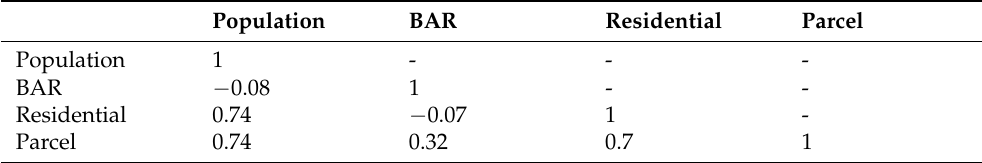
Table 3. Correlation between different types of density variables.